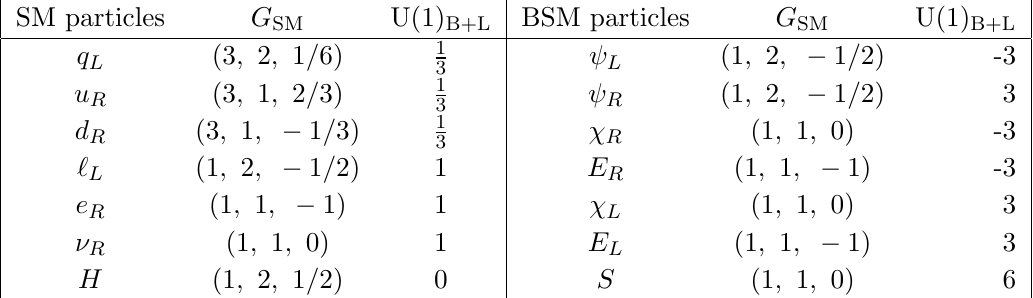
Table 1 . Quantum numbers of (cid:12)elds under the gauge symmetries G SM (cid:2) U(1) B+L , where G SM = SU(3) C (cid:2) SU(2) L (cid:2) U(1) Y